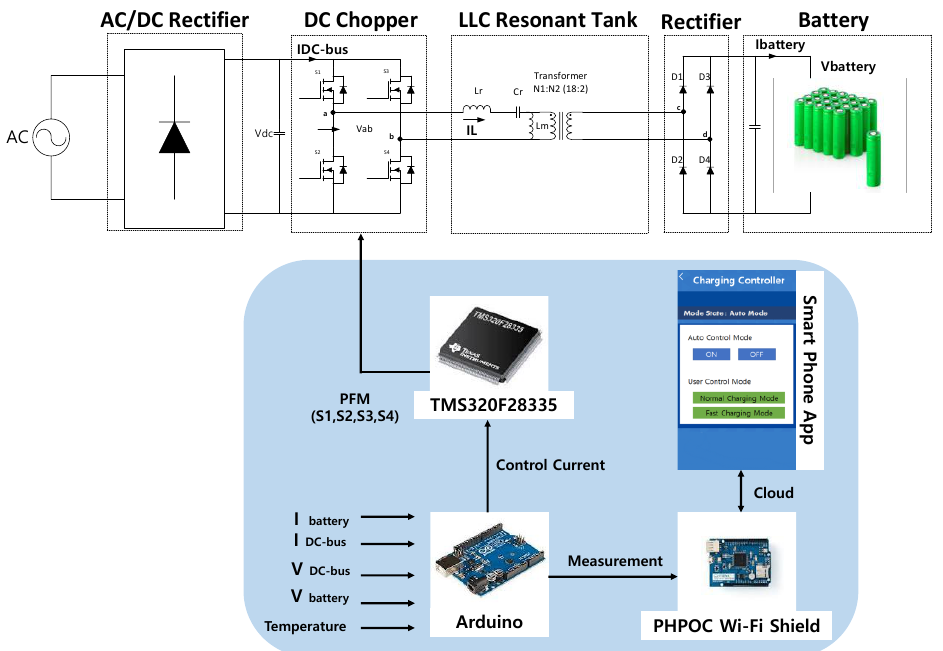
Figure 1. Proposed Real-time monitoring system overview.